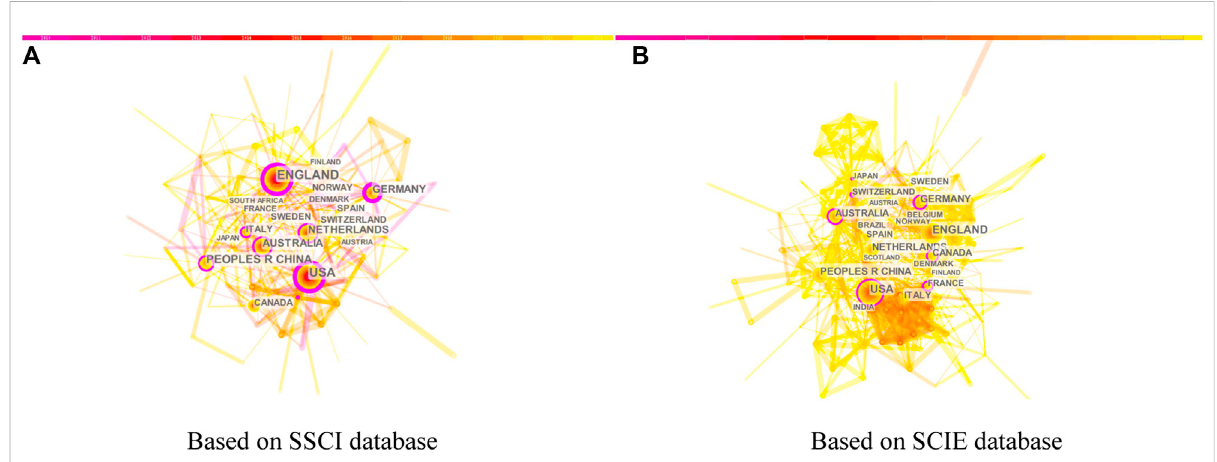
FIGURE 3 Map of the country co-authorship network of climate innovation research. (A) refers to the SSCI database and (B) refers to the SCI database.